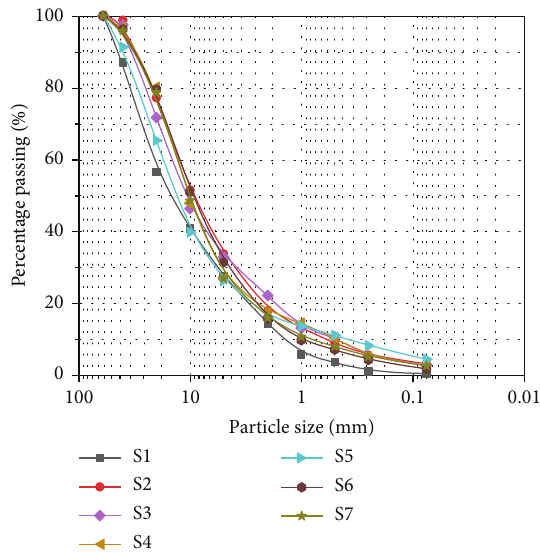
Figure 1: Grain size distribution curve of the coarse-grained fi lling soil.